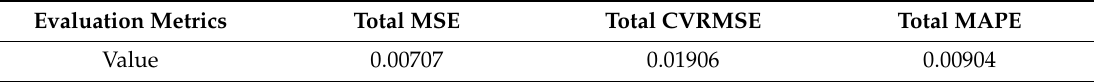
Table 6. Evaluation metrics of predict model for COP after clustering.